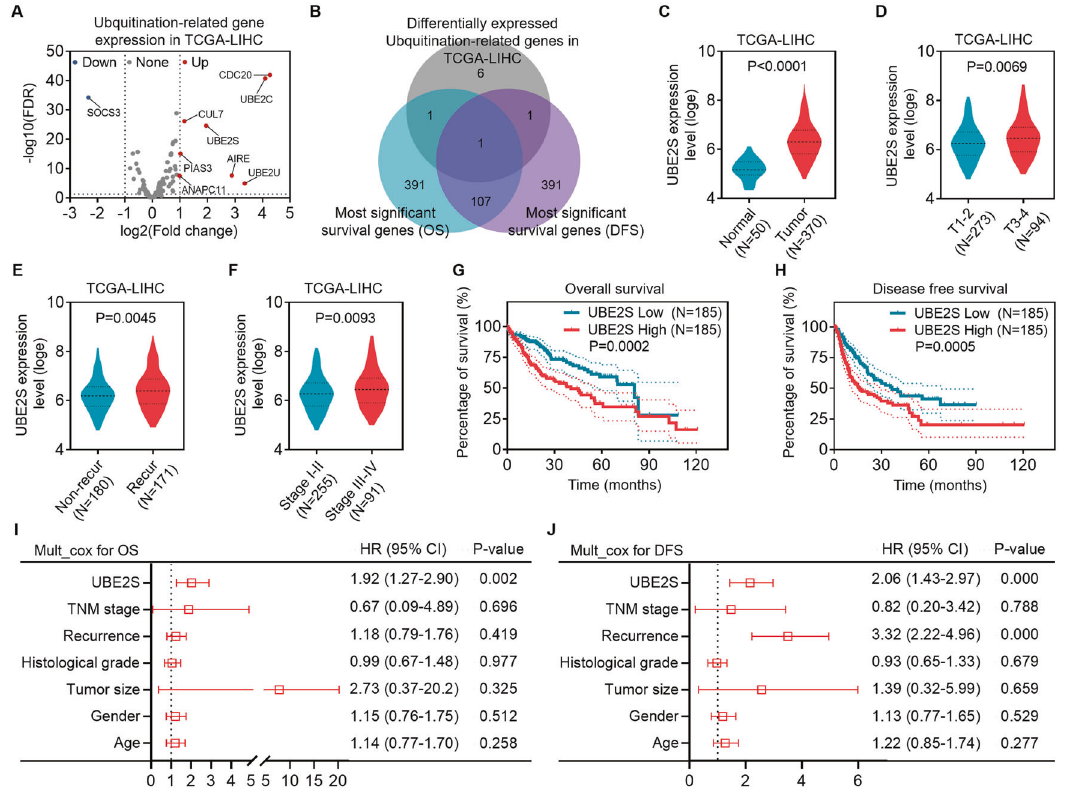
Fig. 1 UBE2S is frequently upregulated in HCC, which is positively associated with a poor prognosis of patients with HCC. A Differentially expressed genes (DEGs) between HCC and non-tumoral tissues in TCGA-LIHC cohorts, involved in ubiquitination process, are shown in a volcano plot. B The overlap among ubiquitination-related DEGs, the genes most signi fi cantly related to overall survival (OS) and disease-free survival (DFS) in TCGA-LIHC database are displayed in a Venn diagram. C Difference in the level of UBE2S transcript between non-tumoral and HCC tissues is presented in a violin plot. D – F Difference in the level of UBE2S transcript between HCC subgroups, including tumor size (D, T1-2 vs. T3-4), recurrence event (E, non-recurrence vs. recurrence) and TNM stage (F, stage I – II vs. stage III-V) is presented in each violin plot, respectively. G , H The OS ( G ) and DFS ( H ) curves for patients with HCC are shown based on UBE2S transcript levels in HCC tissues in TCGA-LIHC cohorts. I , J The independent prognostic factor for OS ( I ) and DFS ( J ) of patients with HCC, based on multivariate Cox proportional hazard model, is showed in each forest plot,